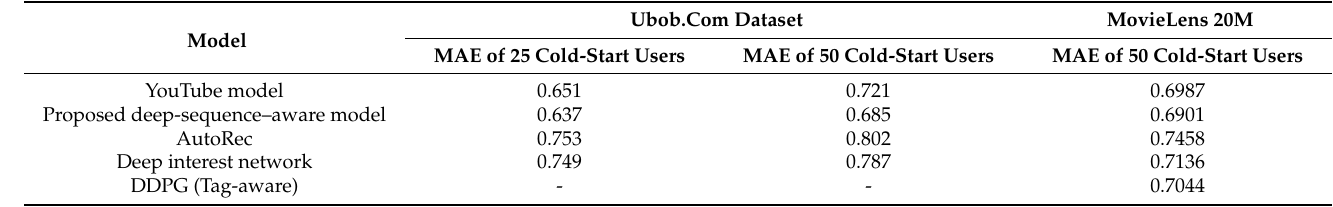
Table 4. User cold-start